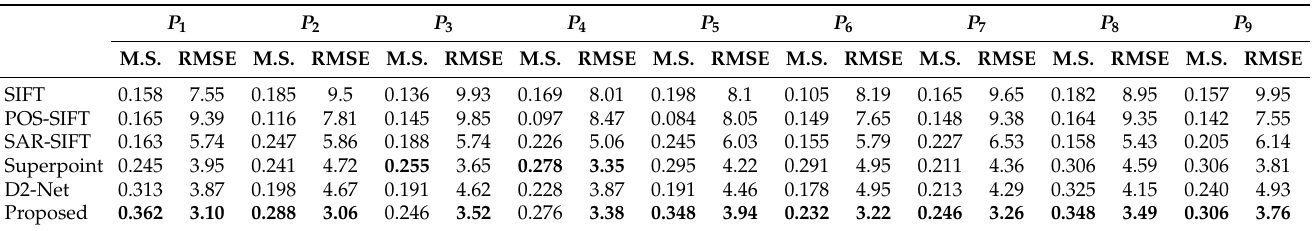
Table 4. The repeatability of matching points. D 1 , D 2 , D 3 , D 4 , D 5 , D 6 are urban, suburban, industrial, pond, port and mountain scenes